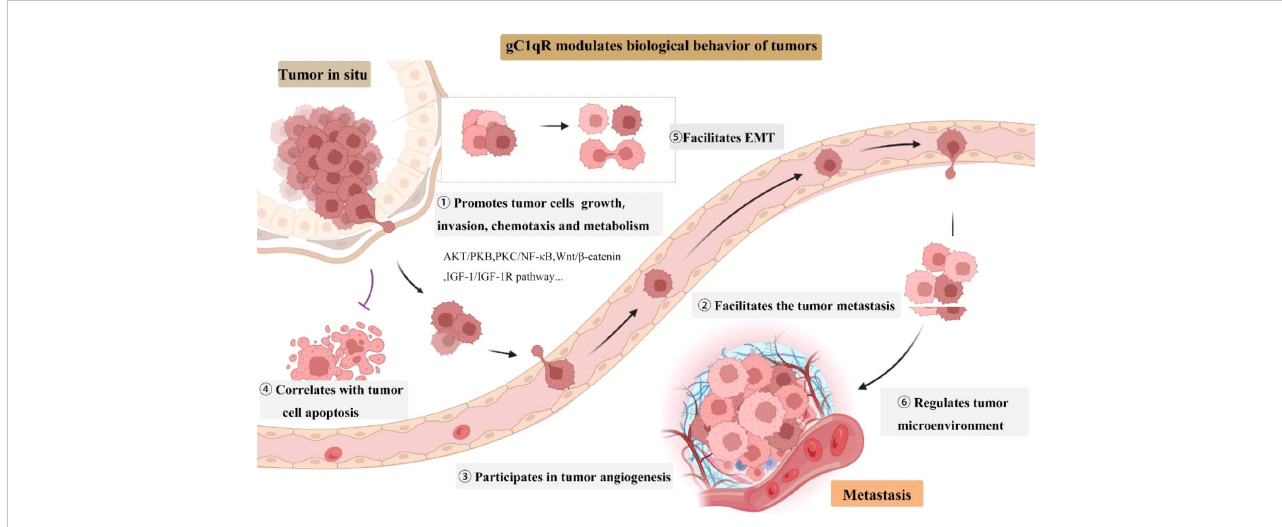
FIGURE 1 gC1qR roles in tumor growth, invasion, and progression. EMT, epithelial to mesenchymal